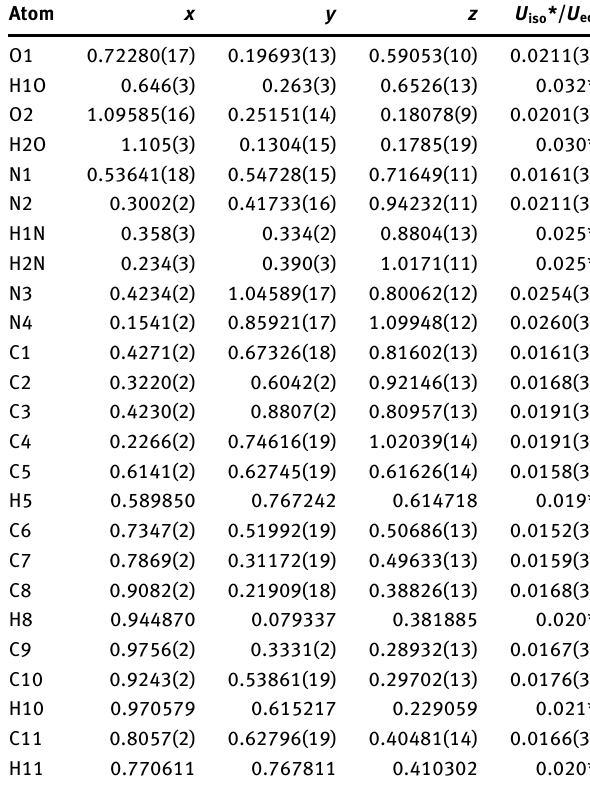
Table 2: Fractional atomic coordinates and isotropic or